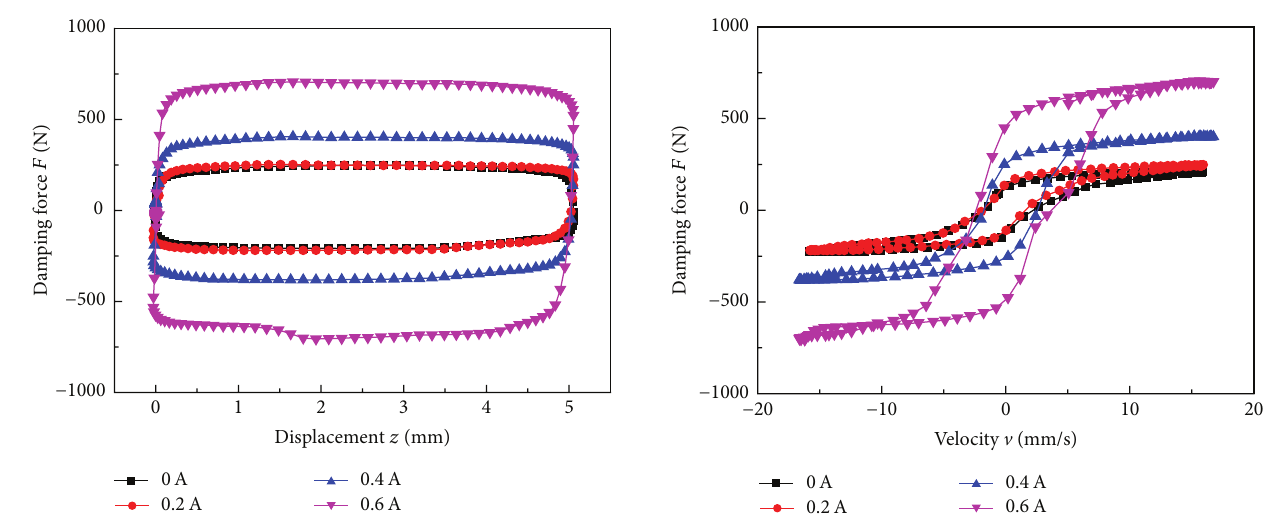
Figure 12: Damping force and velocity relation of the MR